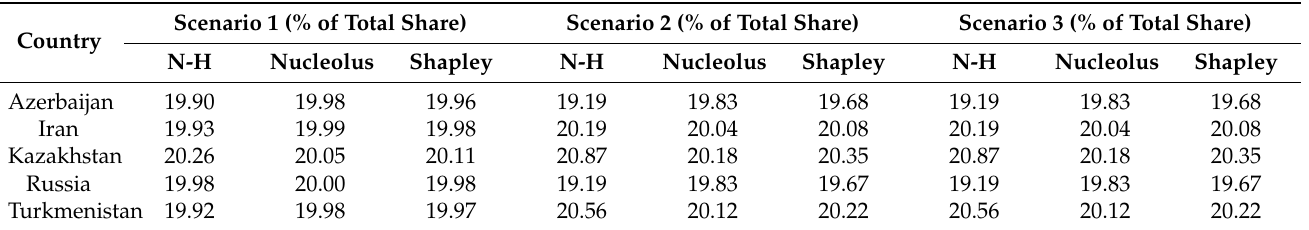
Table 4. Percent of cooperative shares under proposed cooperative game theory methods excluding bargaining power.